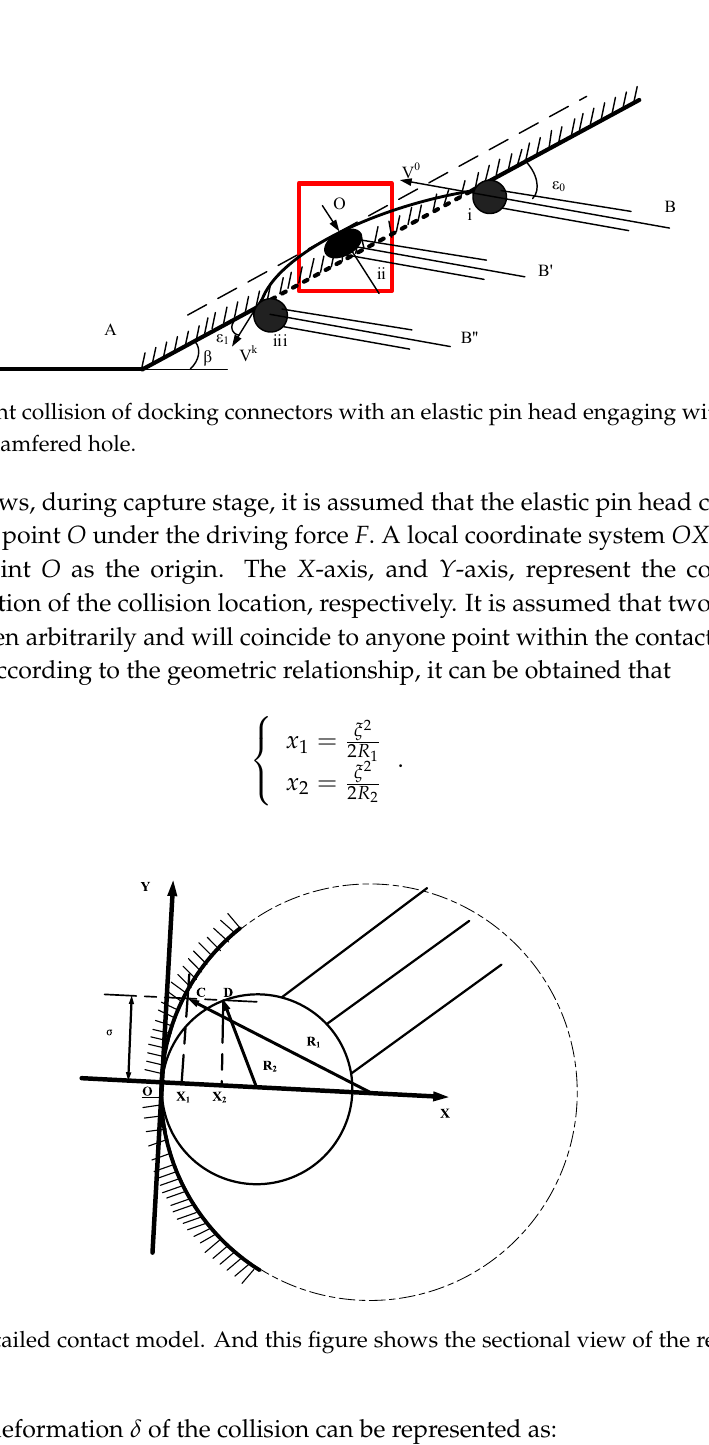
Figure 3. The detailed contact model. And this figure shows the sectional view of the red region in Figure 2.